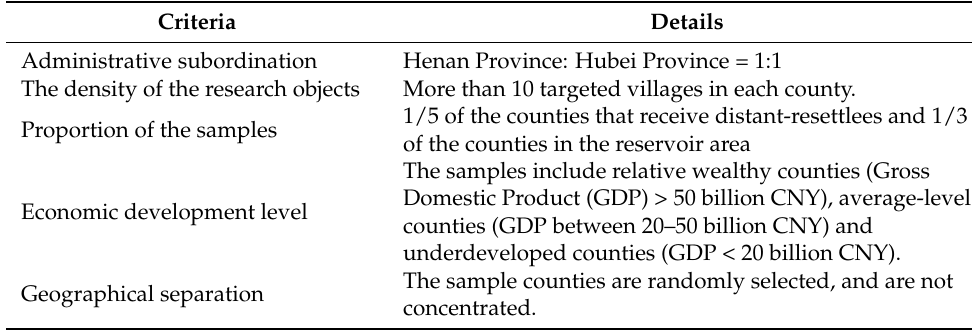
Table 1. The selection of sample counties in the questionnaire